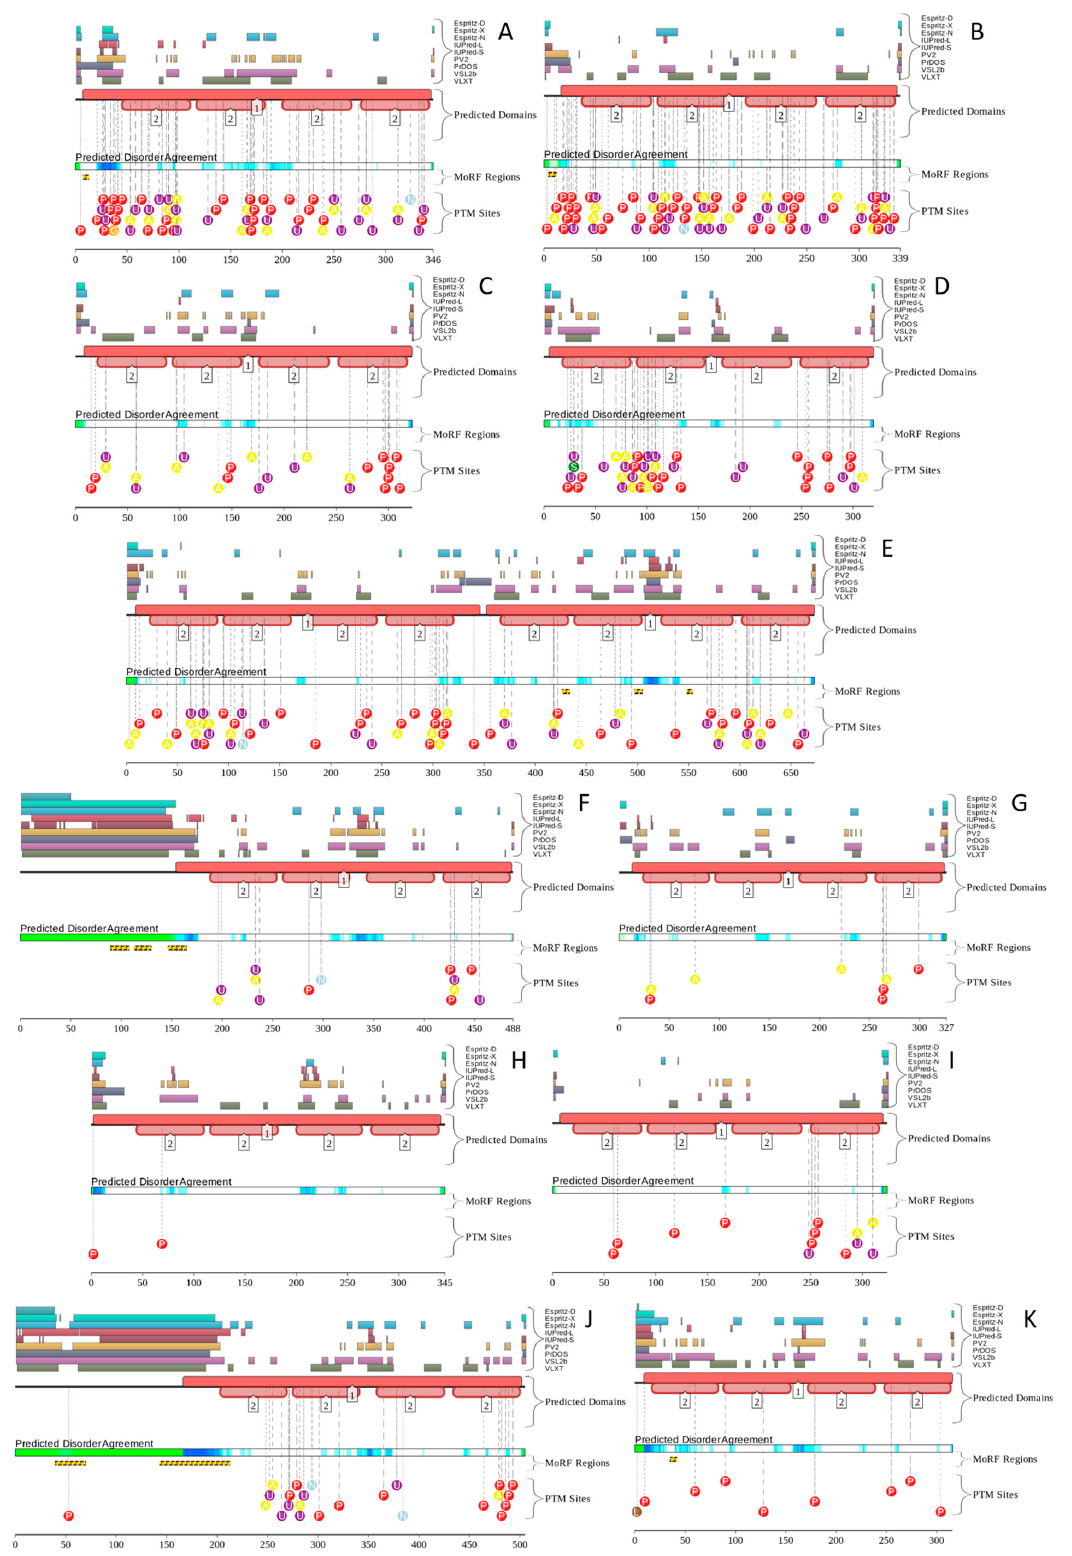
Figure 9. Functional disorder profiles of human annexins generated by the D 2 P 2 platform (http://d2p2.pro) that generates an interactive display that comments on the structural components, disordered segments, post-translational modifications (PTMs), and the presence of disorder-based binding